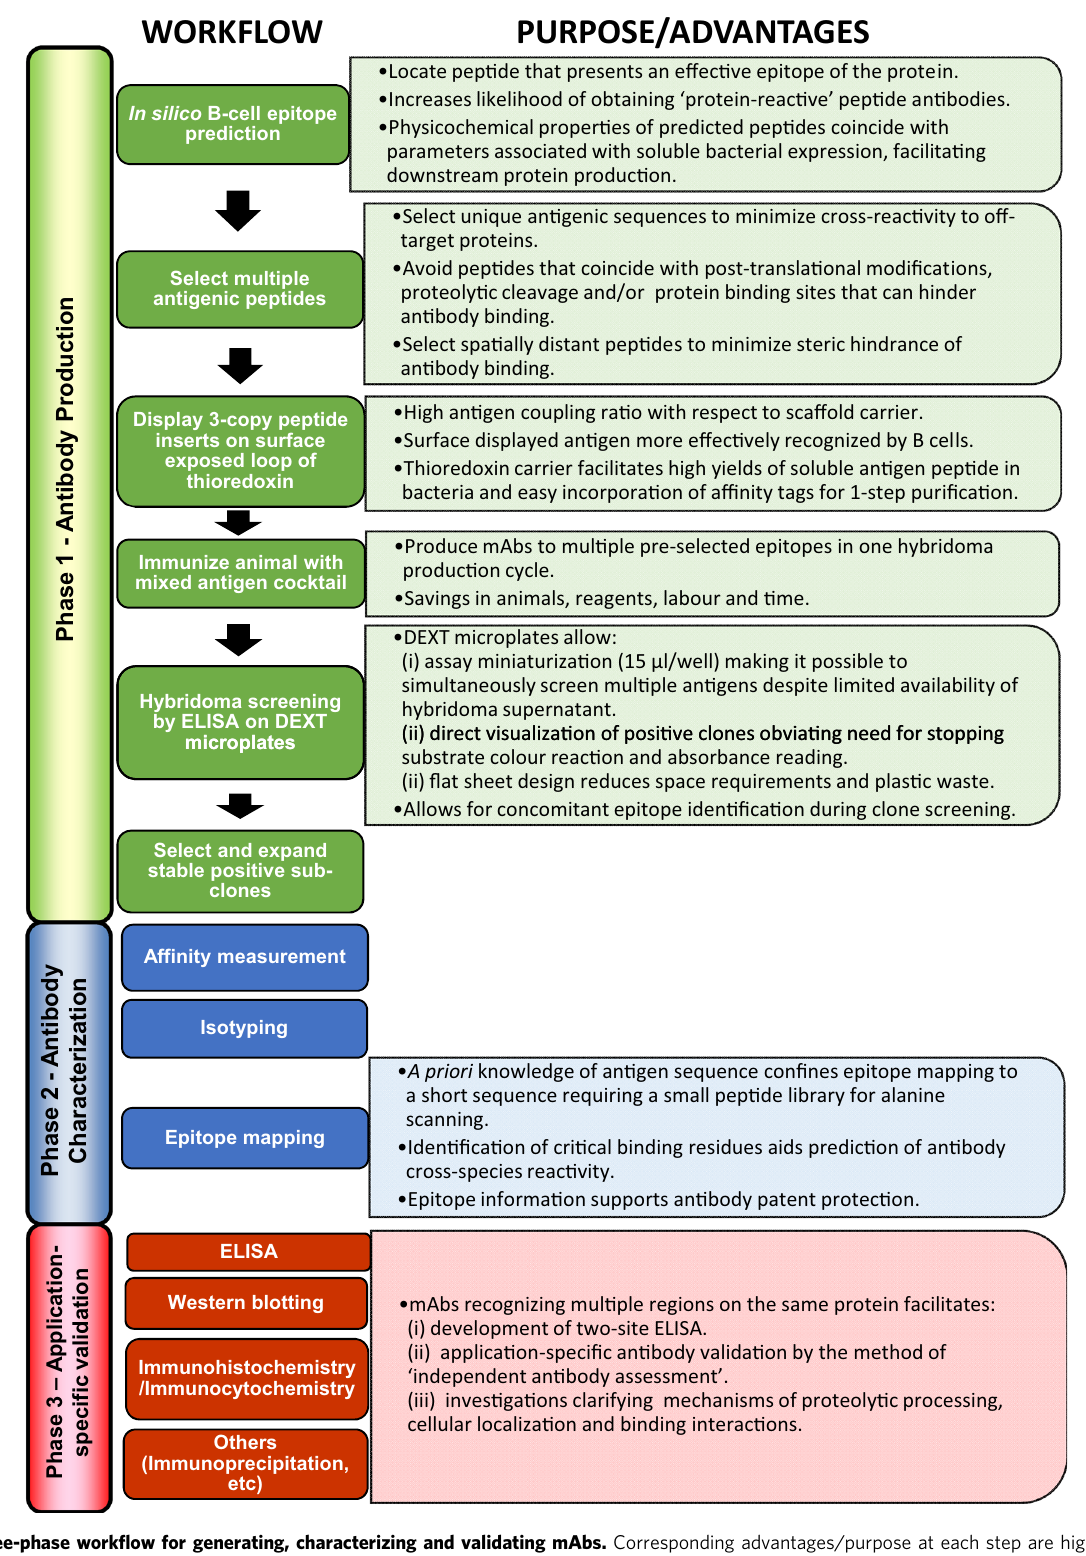
Fig. 1 Three-phase work fl ow for generating, characterizing and validating mAbs. Corresponding advantages/purpose at each step are